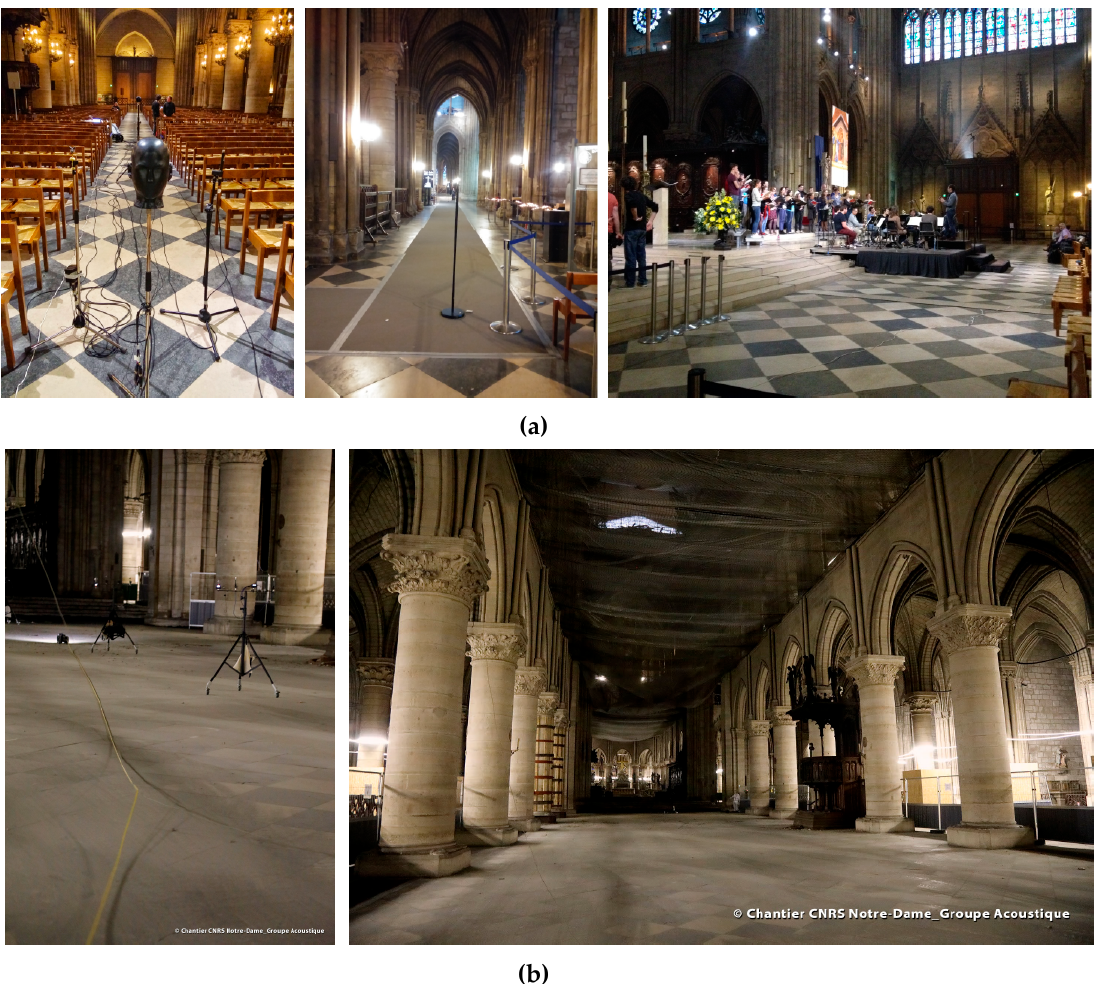
Figure 2. Photos of conditions for the ( a ) 2015, highlighting measurement equipment, carpet runner, and small concert risers in place during the measurement session; ( b ) 2020, highlighting microphone tripods pulled by remote controlled robot, barrier, and general empty state of the nave during the measurements.